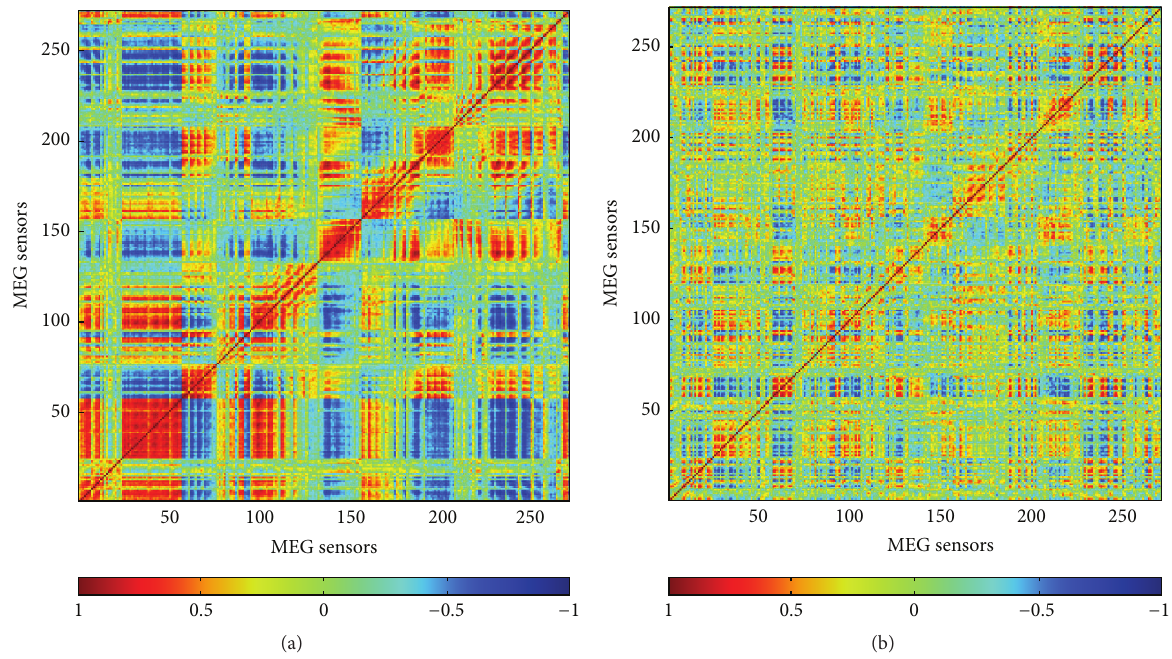
Figure 4: (a) Correlation coefficient matrix of real spontaneous MEG noise from a randomly selected trial. (b) Correlation coefficient matrix of real spontaneous MEG noise after being projected to a new space defined by the orthogonal complement of dominant eigenvectors of real MEG noise from another trial. The sum of absolute values of nondiagonal elements in (a) is 1.6 times larger than that in (b), implying that the spatial correlation between MEG noise can be decreased by the prewhitening operation. Colorbar indicates the values of correlation